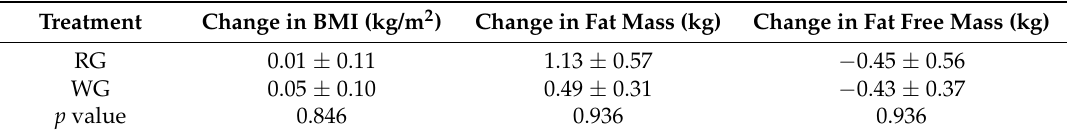
Table 4. Change in body mass index and body composition over the six ‐ week intervention for refined grain (RG) and whole grain (WG) and treatments 1,2 .